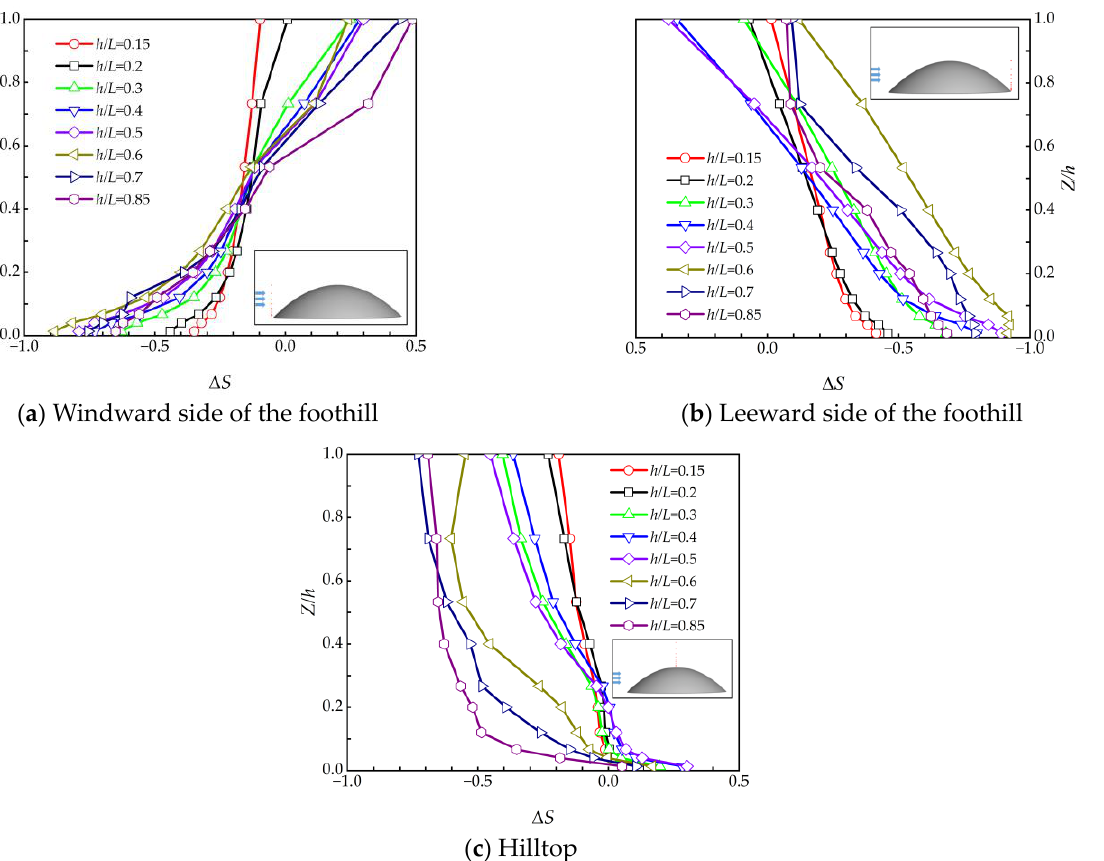
Figure 11. Hilltop speedup ratio with different slopes. Figure 12 shows the trend of the distribution of speedup ratios along the windward and leeward sides of the hill model for slopes of 0.3, 0.5, and 0.7, respectively. Figure 12a shows the results of dimensionless processing of the speedup ratio on the windward side of the hill model at different slopes with the maximum speedup ratio value. The compar- ison with Equation (7) shows the same trend, so it can be considered that the speedup ratio on the windward side at different slopes can be expressed by using Equation (7). Figure 12b shows the dimensionless speedup ratios on the leeward side at different slopes and, compared with Equation (8), it is found that the agreement is better, so Equation (8) can express the speedup ratios at different slopes.